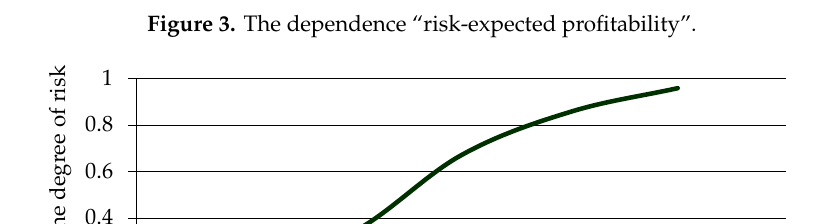
Figure 3. The dependence “risk-expected profitability”.